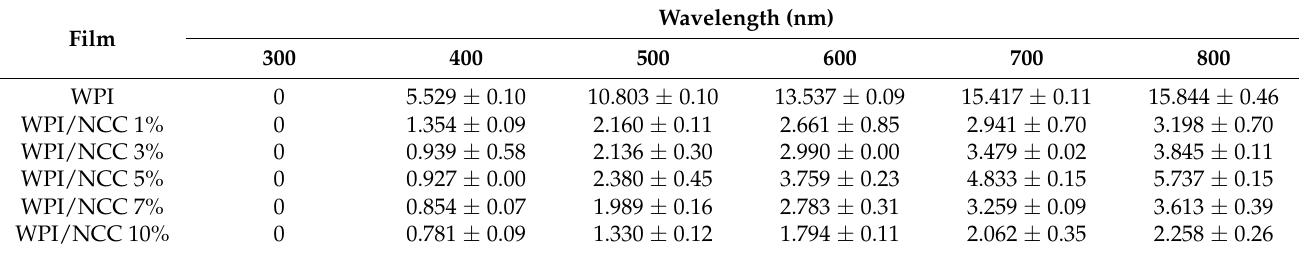
Table 3. Transparency of whey protein film combined with nanocrystalline